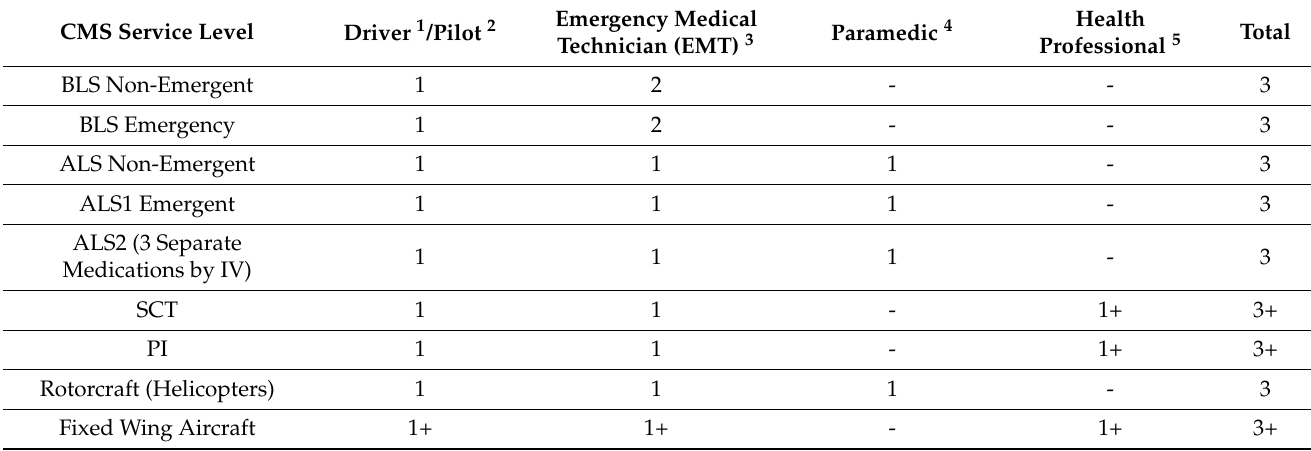
Table 2. Crew service